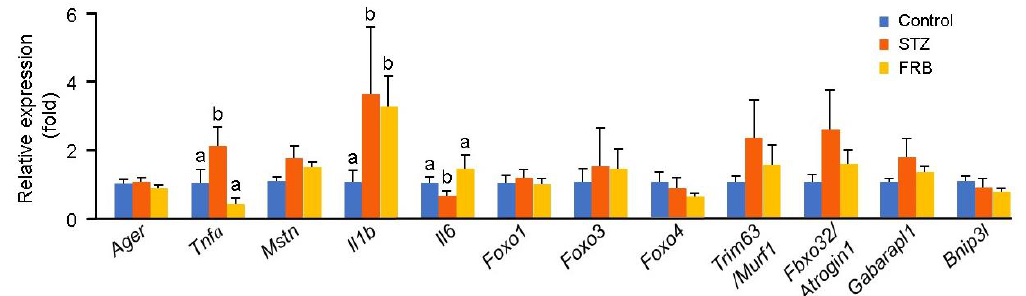
Figure 4. FRB supplementation influenced the expression of muscle regulatory genes. Data are shown as the means + SEM. Significance ( p < 0.05, n = 5) among groups is denoted by different letters (a, b).